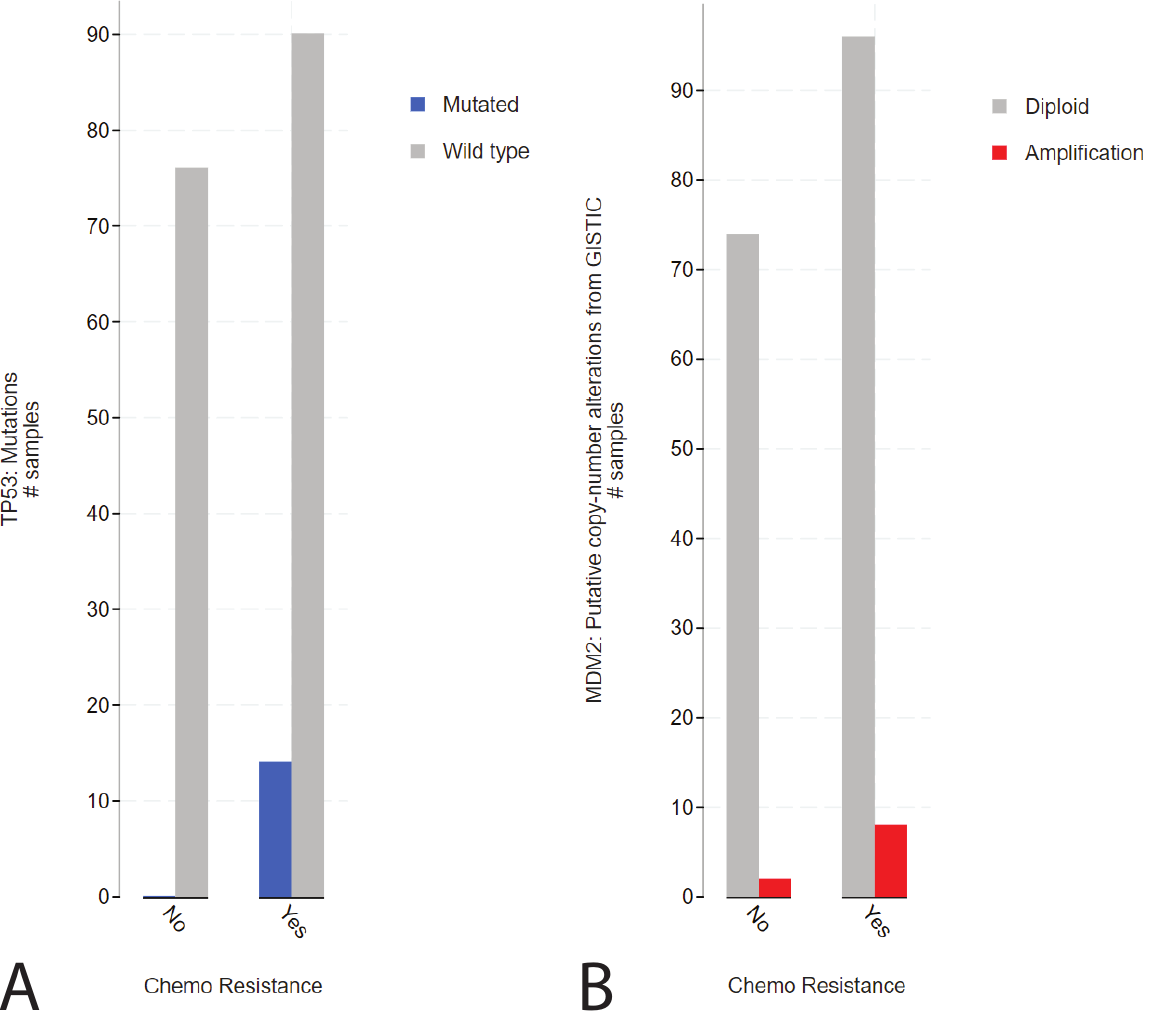
A B Figure 1. cBioPortal analysis of the tumor resistance in TP53 - or MDM2 -altered patients in the MSKCC, J Clin Oncol 2016 data set. ( A ) Bar graph displaying the number of patients with sensitive or resistant cisplatin, patients harboring wild-type (grey) or mutated (blue) TP53 are plotted. ( B ) Bar graph displaying the number of patients with sensitive or resistant cisplatin, patients harboring wild-type (grey) or amplified (red) MDM2 are plotted